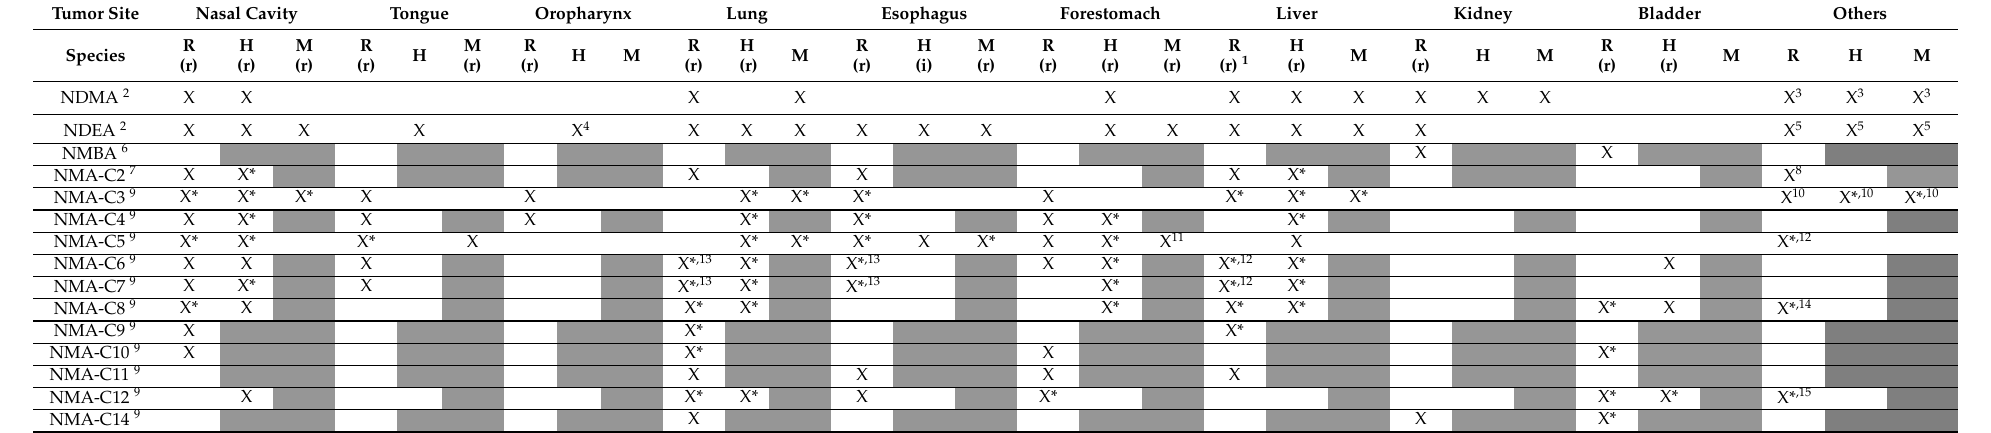
Table 2. Summary of statistically significant tumors and increased rare tumors in rats, hamsters, and mice exposed to NMAs (including NDMA), NDEA, and NMBA. Tumor Site Nasal Cavity Tongue Oropharynx Lung Esophagus Forestomach Liver Kidney Bladder Others